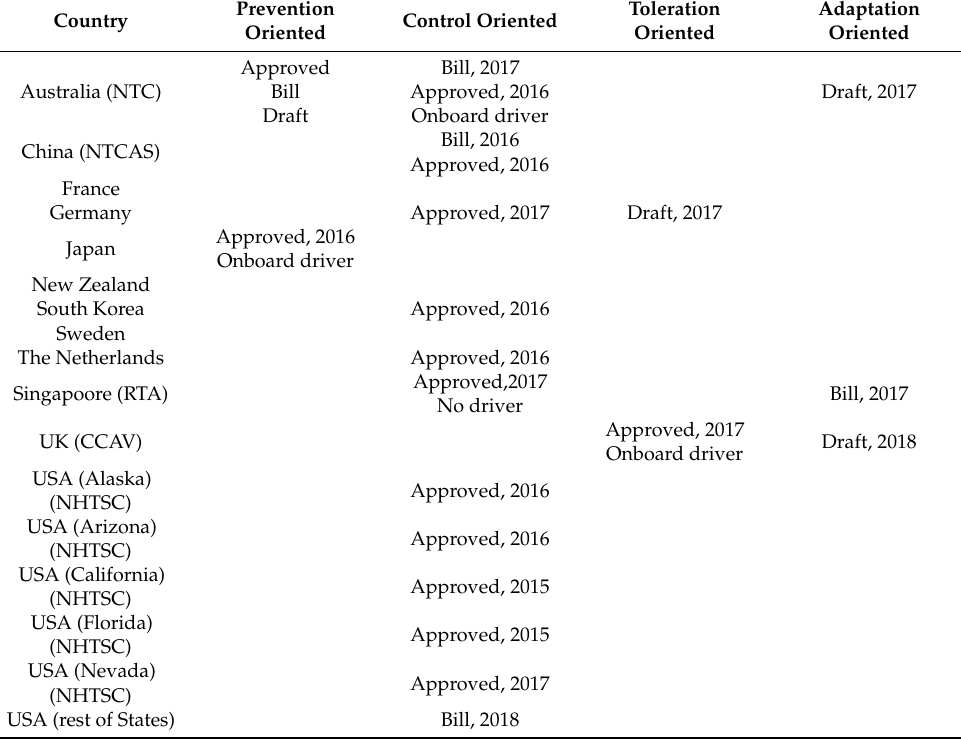
Table 8. Summary of the main AV legal